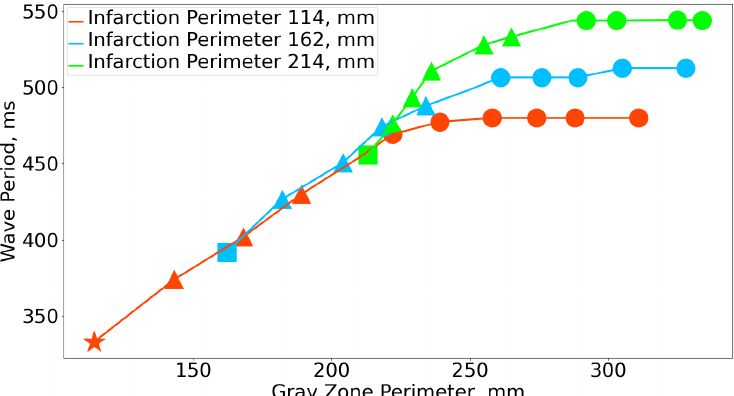
Figure 7. Dependence of the wave rotation period on the perimeter of the gray zone for different perimeters of the infarction scar. A star indicates functional rotation , a triangle indicates gray zone rotation , a square indicates scar rotation , and a circle indicates scar rotation two